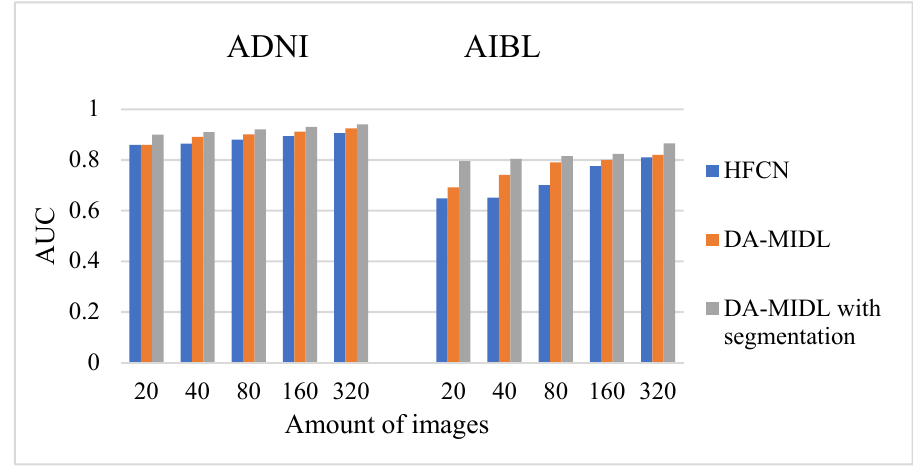
Figure 7. AUC comparison outcomes between DA-MIDL, HFCN, and proposed DA-MIDL with segmentation.